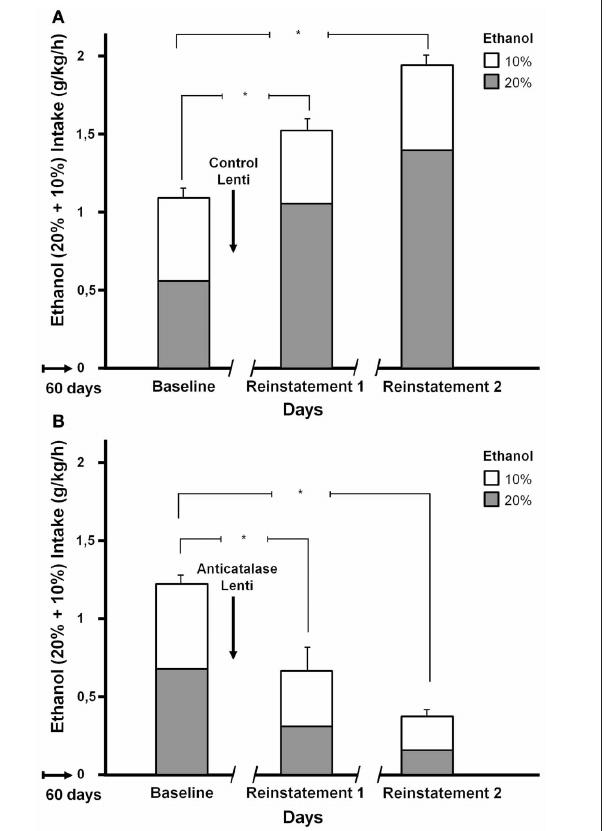
FIGURE 6 | Increased ethanol intake by UChB rats chronically exposed to ethanol, subsequently deprived and ethanol re-exposed. Marked inhibition of intake following the administration of an anticatalase lentiviral vector. Animals with ad-libitum access to 10 and 20% ethanol and water for 60 days. Baseline data correspond to the average of ethanol intake restricted to only 1h a day, for 7 days immediately prior to alcohol deprivation. A single intra-ventral tegmental area injection of an anticatalase-lentiviral vector inhibited the first 1-h ethanol intake after the first and second ethanol deprivation (ADE) periods of 15 days. The total height of each bar represents the sum of ethanol intake (g ethanol/kg/60min) of the 10% solution (empty bars) plus that of the 20% solution (gray bars). The -/ /- symbol in the x -axis represents the 15-day deprivation period. (A) Control viral vector. (B) Anticatalase viral vector. Arrows indicate the administration of either control lentiviral vector or anticatalase-lentiviral vector prior to the 15 days of deprivation. The first and second re-exposure consumptions were significantly different from baseline. The inhibition induced by anticatalase vector administration was 67% ( p < 0 . 001) after the first deprivation period, and 80% ( p < 0 . 001) after the second deprivation period. Note also the marked increases in ethanol binge-drinking induced in control vector treated animals after the first and second ethanol intake and deprivation cycles (From Tampier et al.,